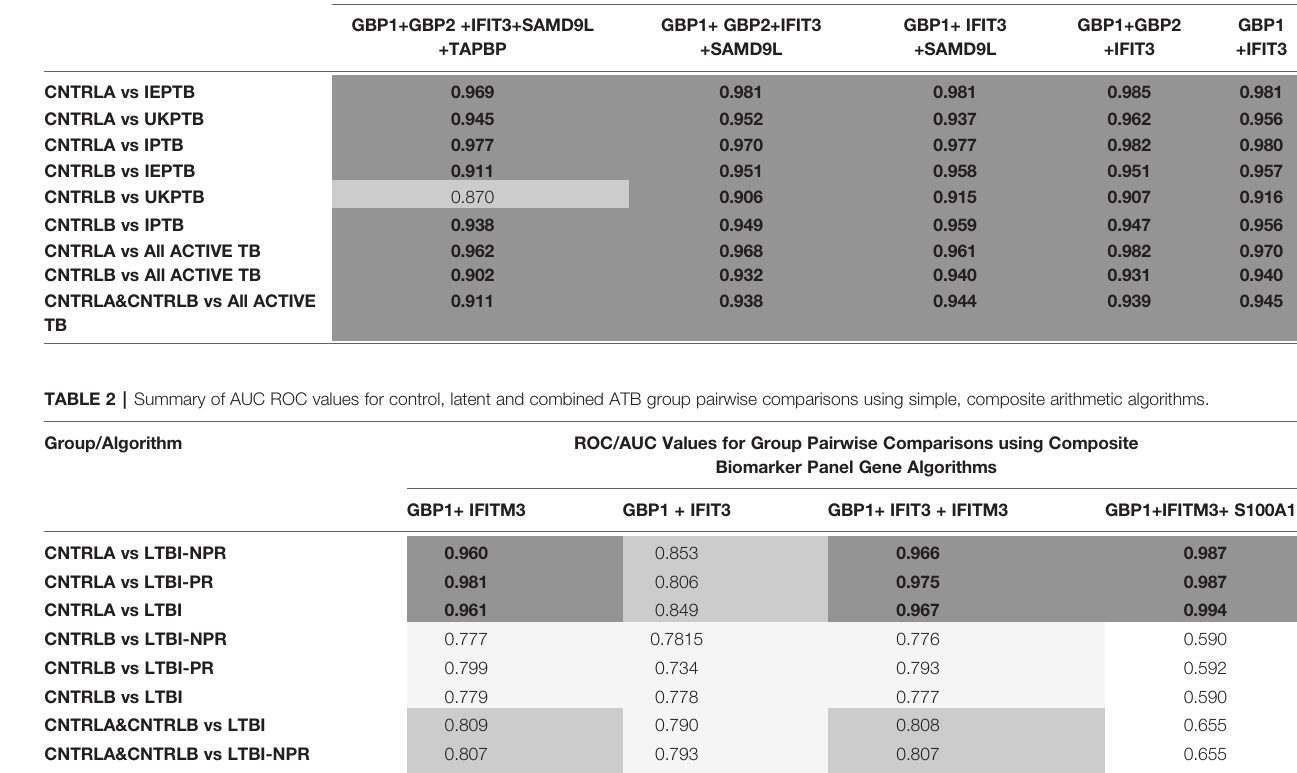
TABLE 1 | Summary of AUC ROC values for control and ATB group pairwise comparisons using simple, composite arithmetic algorithms. Group/Algorithm